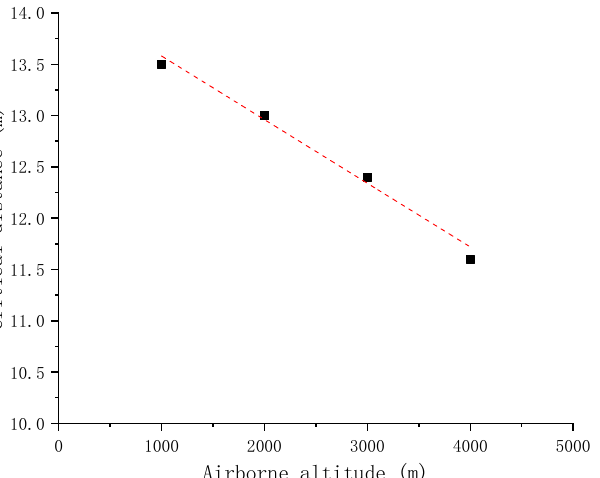
Figure 12. Critical distances between parachute systems at different airborne altitudes.